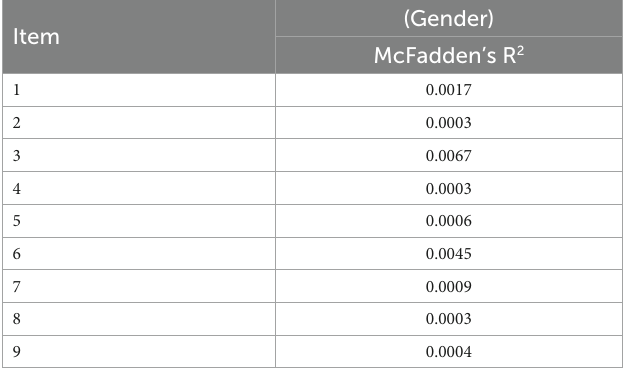
TABLE 7 Results of functional differences in items on